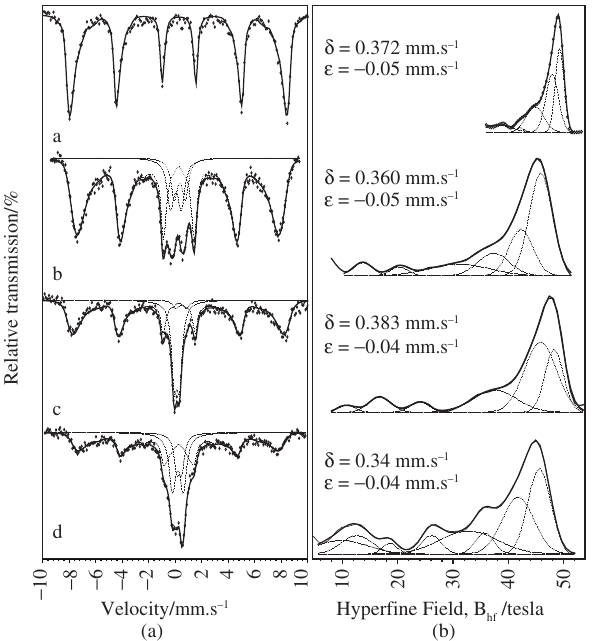
Figure 4. Mössbauer spectra of the LaFe and the 50, 33 and 25 wt% supported on Al distributions (right side).